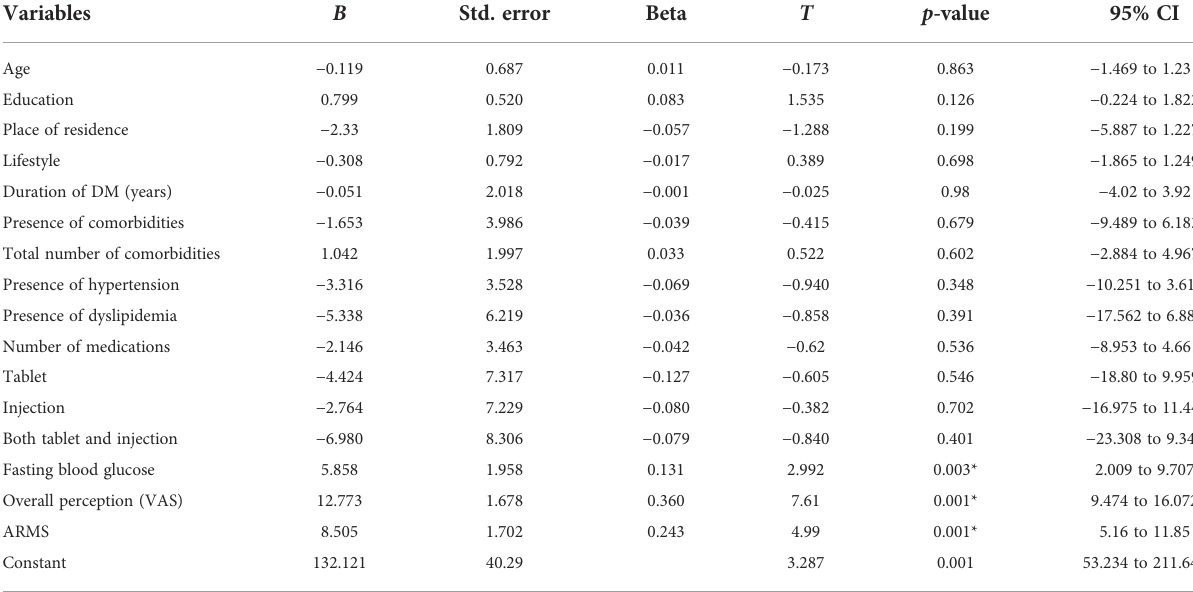
TABLE 4 Multiple linear regression LMQ-3 score versus sociodemographics and medicine-use characteristics in DM patients attending at Felege Hiwot Comprehensive Specialized Hospital. Variables B Std.